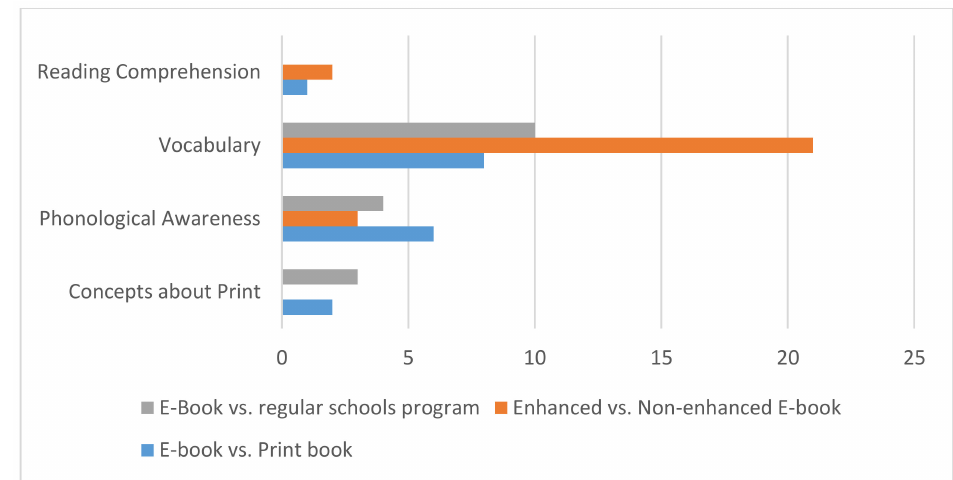
Figure 3. Number of literacy outcomes in the three compared